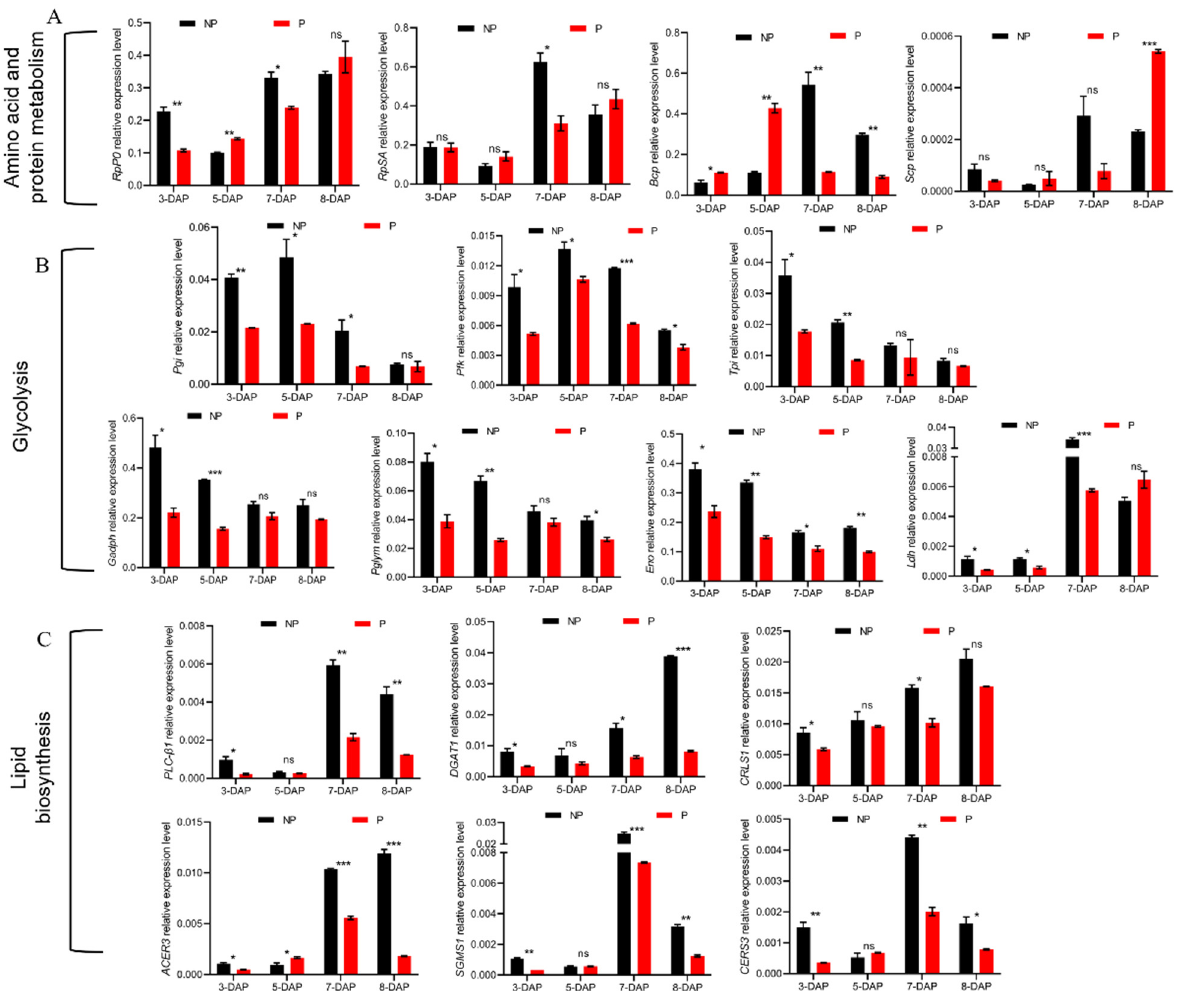
Figure 3. Effects of E. japonica parasitism on the expression levels of genes involved in amino acid and protein metabolism, carbohydrate metabolism, and lipid biosynthesis of B. mori at 3-, 5-, 7- and 8-DAP. ( A ) The relative expression levels of genes involved in amino acid and protein metabolism. ( B ) Expression levels of metabolic genes involved in glycolysis pathway. ( C ) RT-qPCR analysis of the expression levels of key enzymes involved in lipid biosynthesis. All transcriptional data were normalized to the expression level of Rp49 . The statistical significance is indicated by * p < 0.05, ** p < 0.01 or *** p < 0.001. The results are shown as the mean ± S. D. Table 2. Classification of DEGs involved in host energy and nutrient metabolism.